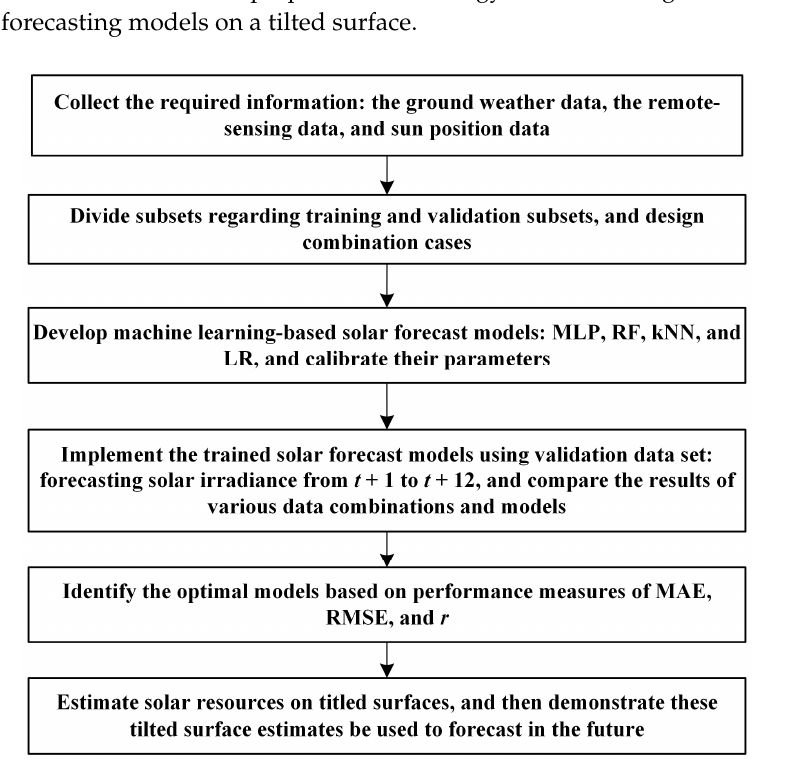
Figure 2. Flowchart of the proposed methodology.